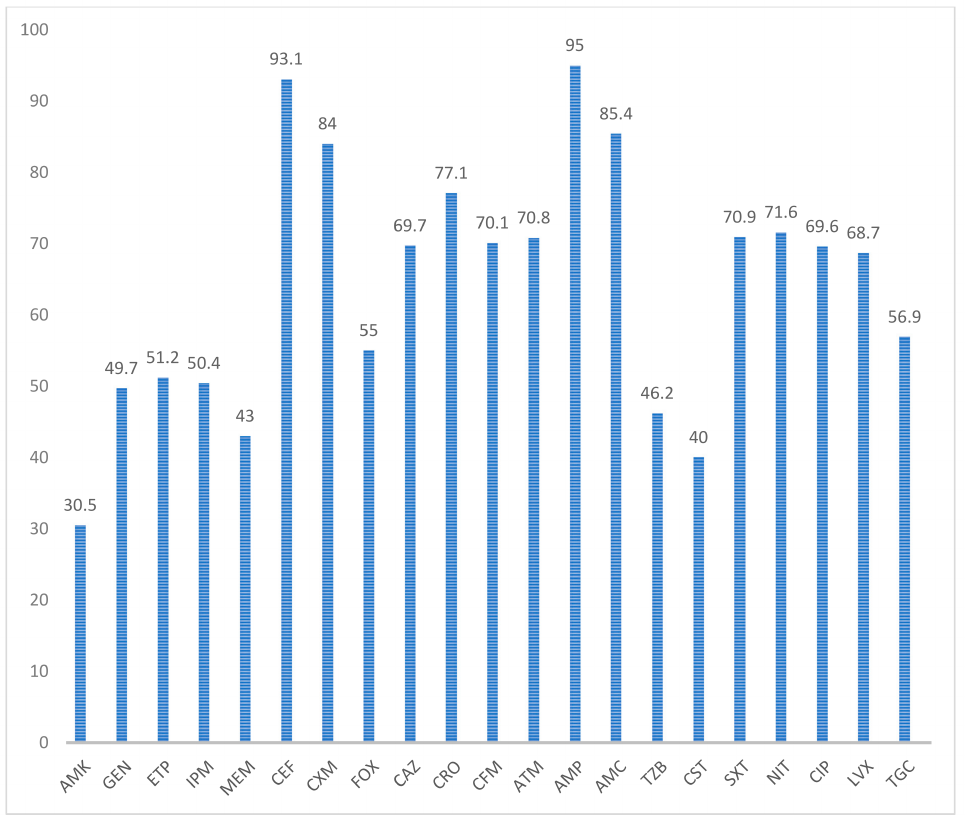
Figure 2. Antimicrobial resistance exhibited by Gram-negative organisms: amikacin (AMK), gentamicin (GEN), ertapenem (ETP), imipenem (IPM), meropenem (MEM), cephalothin (CEF), cefuroxime (axetil or sodium) (CXM), cefoxitin (FOX), cef- tazidime (CAZ), ceftriaxone (CRO), cefepime (FEP), aztreonam (ATM), ampicillin (AMP), amoxicillin/clavulanic acid (AMC), piperacillin/tazobactam (TZP), colistin (CST), trimethoprim/sulfamethoxazole (SXT), nitrofurantoin (NIT), ciprofloxacin (CIP), levofloxacin (LVX), tigecycline (TGC). Overall, 45 (10.3%) were resistant to less than three antibiotic classes, while 372 (85.1%) were multidrug resistant, which also included 125 (28.6%) of the